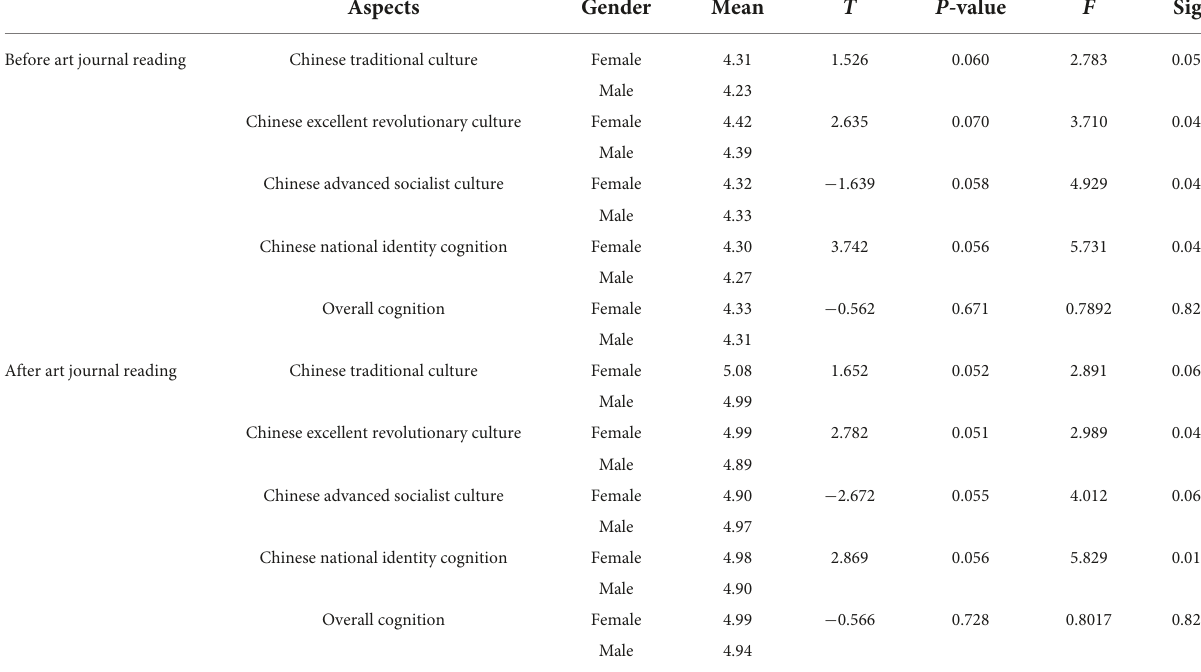
A comparison chart is plotted based on the means in Table 3 , as shown in Figure 2